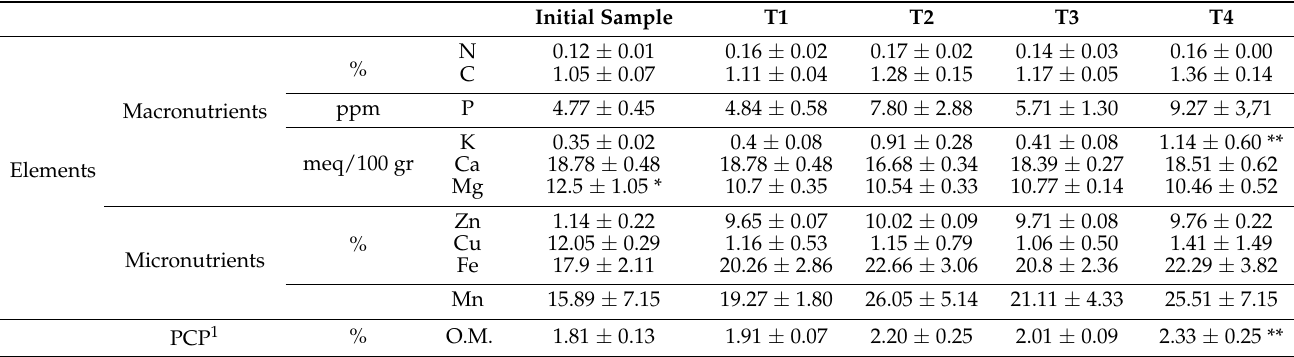
Table 3. Soil concentration of macro- and micronutrients, determined in T1: no mulch + 251 mm of water; T2: with mulch + 251 mm of water; T3 no mulch + 129 mm of water; T4: with mulch + 129 mm of water. Initial Sample T1 T2 T3 T4 % Macronutrients Elements